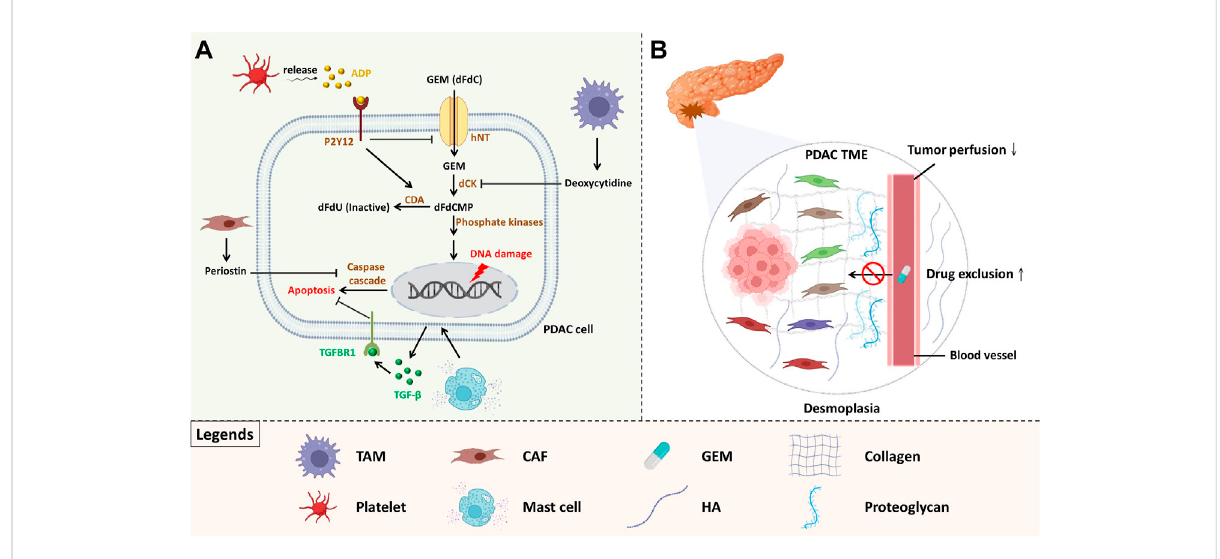
FIGURE 1 The components within the PDAC TME facilitate chemoresistance. (A) Chemoresistance conferred by tumour microenvironmental cells GEM resistance can be conferred by the components within the PDAC TME by modulating drug metabolism and enhancing antiapoptotic effects. (B) Desmoplasia and poor tumour perfusion spatially exclude GEM Activated CAFs induce ECM deposition, resulting in poor perfusion, forming a physical barrier and considerably compromising the access of GEM to tumour